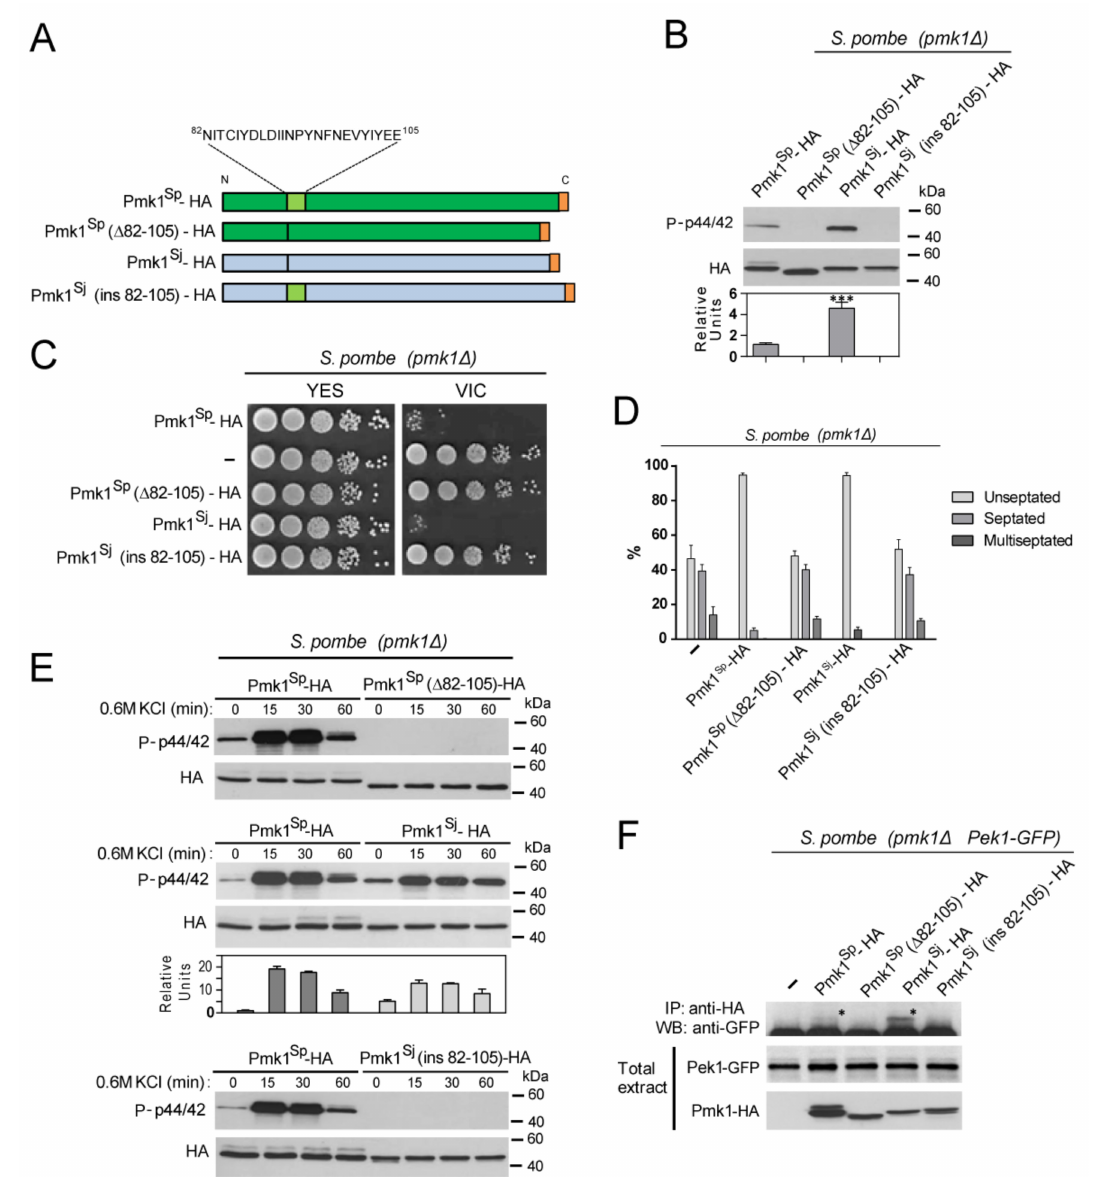
Figure 3. S japonicus Pmk1 is fully functional in S. pombe . ( A ) S. pombe and S. japonicus Pmk1–HA chimeric